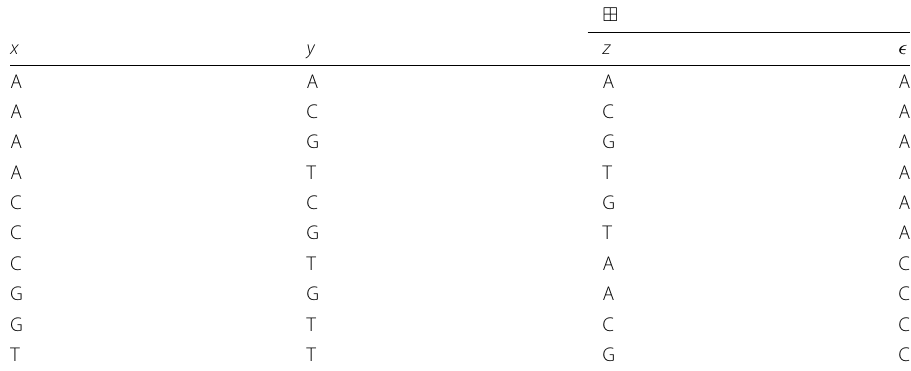
Table 5 Nucleotide operations